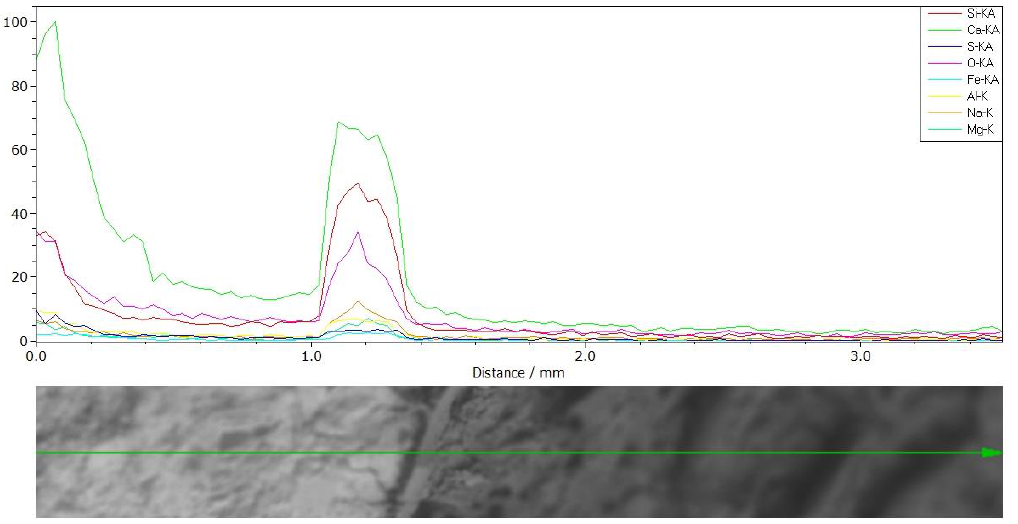
Figure 5. EDS sodium silicate